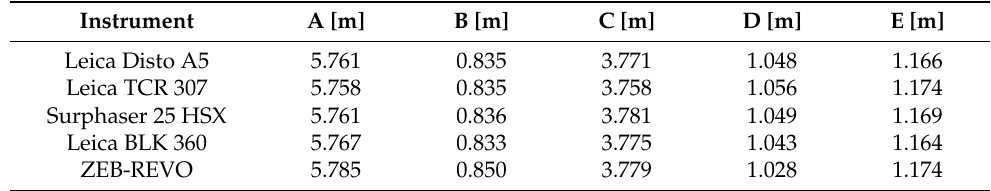
Table 1. Results of selected measured distances (A, B, C, D, E) using different instruments.